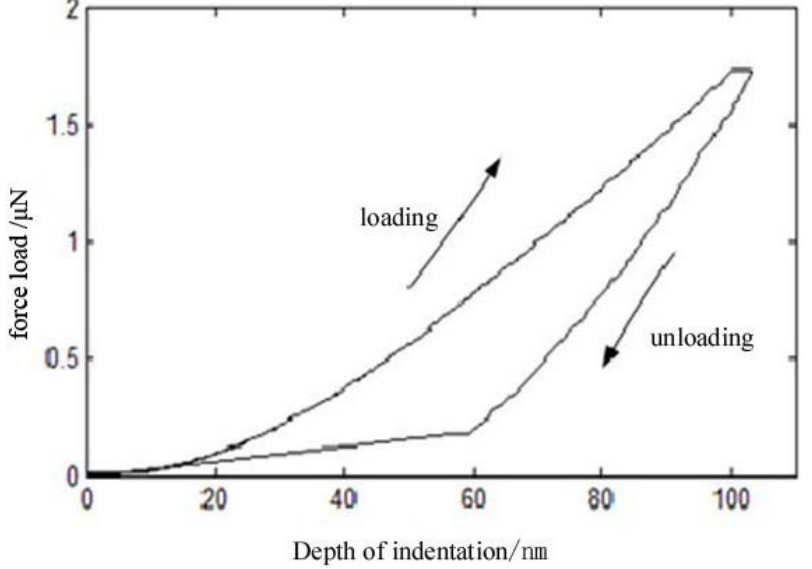
Figure 9. Nanoindentation loading and unloading curves.